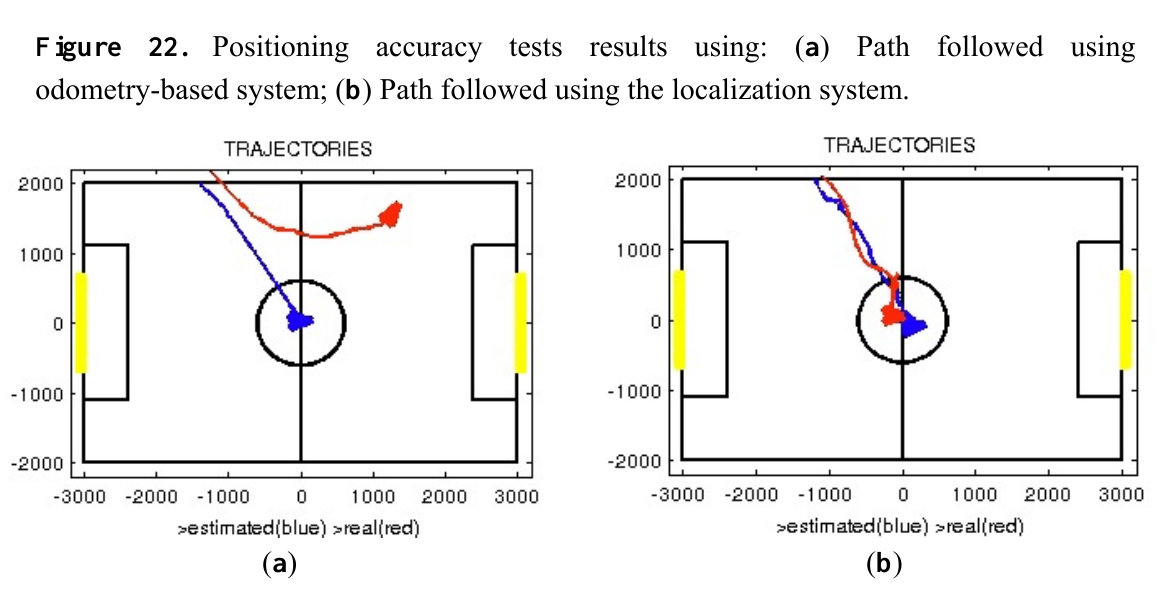
Figure 23. Results of the ‘kidnapped robot’ test using the proposed resampling PF (time is relative to